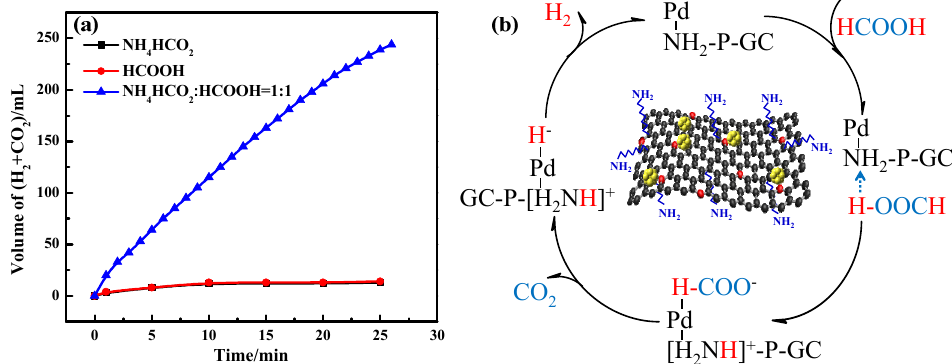
Figure 6. ( a ) Gaseous generation during the decomposition of different reagents with respect to time in the presence of Pd/P-GC. ( b ) Schematic illustration of plausible mechanism for the decomposition of FA over Pd/NH 2 -P-GC.